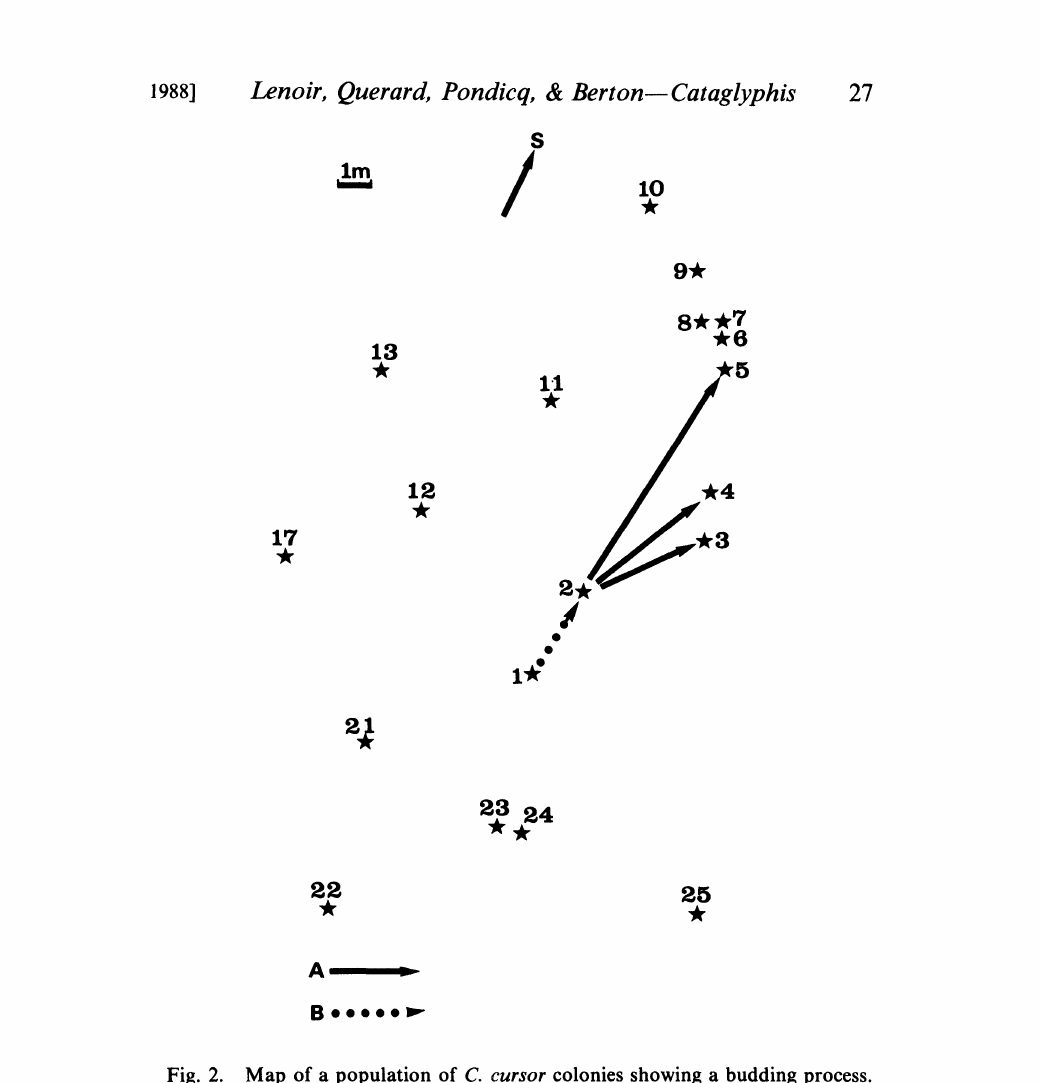
Fig. 2. Map of a population of C. cursor colonies showing a budding process. Asterisks indicate positions of the nests. A: fission of colony 2 into 3 daughter colonies 3, 4, and 5. B: second step nest-moving of colony to the abandoned nest site